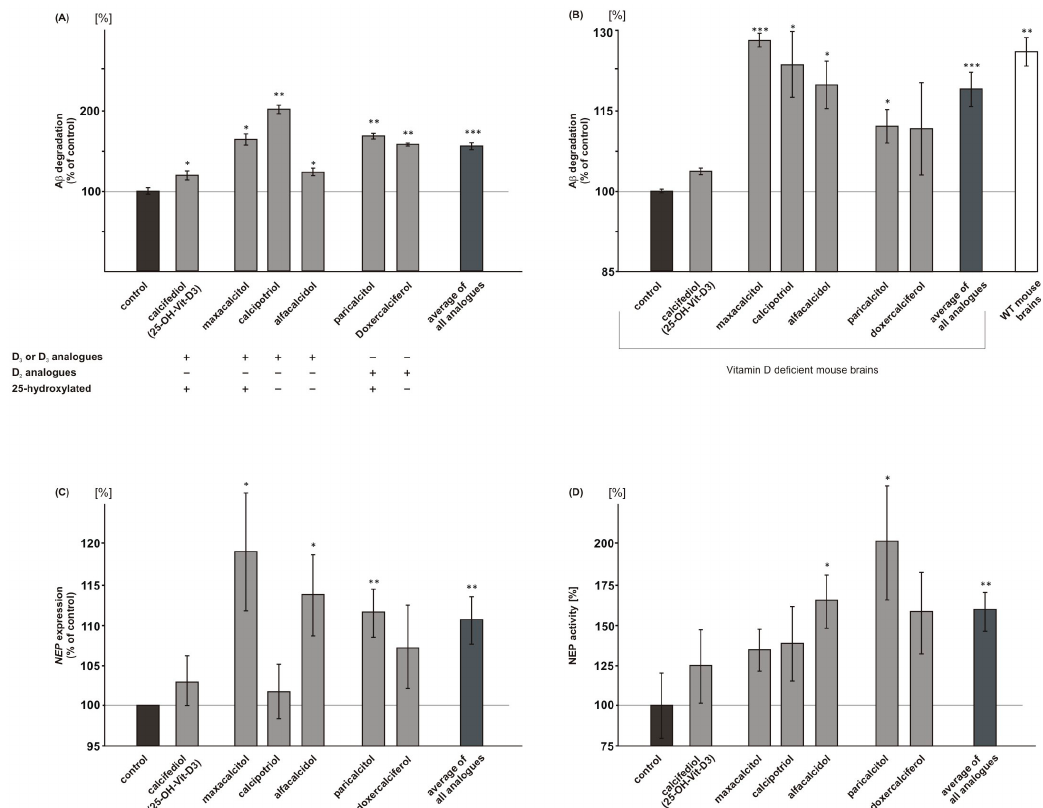
Figure 4. Effect of vitamin D and analogues on A β catabolism. Vitamin D and its analogues influence A β -degradation. Total A β -degradation in ( A ) mouse neuroblastoma N2a wt cells ( n = 3) and ( B ) vitamin D deficient mouse brains ( n = 5). Calcifediol and its analogues increased the A β -degradation compared to solvent control. ( C ) RT-PCR analysis of NEP expression in SH-SY5Y wt cells ( n = 3). ( D ) NEP activity in N2a cells ( n = 8). Error bars represent the standard error of the mean. Asteriks show the statistical significance calculated by unpaired Student’s t test (* p ≤ 0.05; ** p ≤ 0.01; *** p ≤ 0.001).